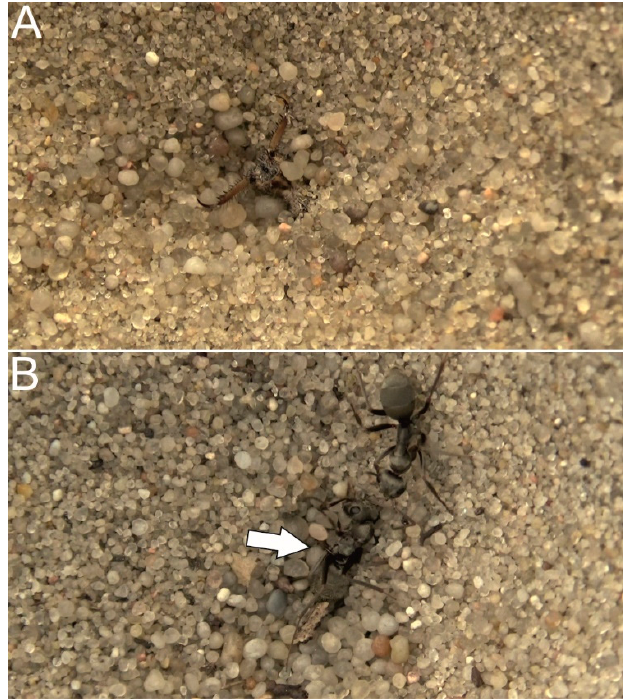
Figure 3. Rescue behavior test with the use of a predatory antlion larva. Close-up view of the antlion in wait for the prey at the bottom of the funnel-shaped trap ( A ). The victim ant ( F. cinerea ), captured by the antlion, and the potential rescuer (nestmate of the victim), making contact ( B ). The arrow indicates the mandibles of the antlion, holding the victim in place. Photographs: F. Turza.